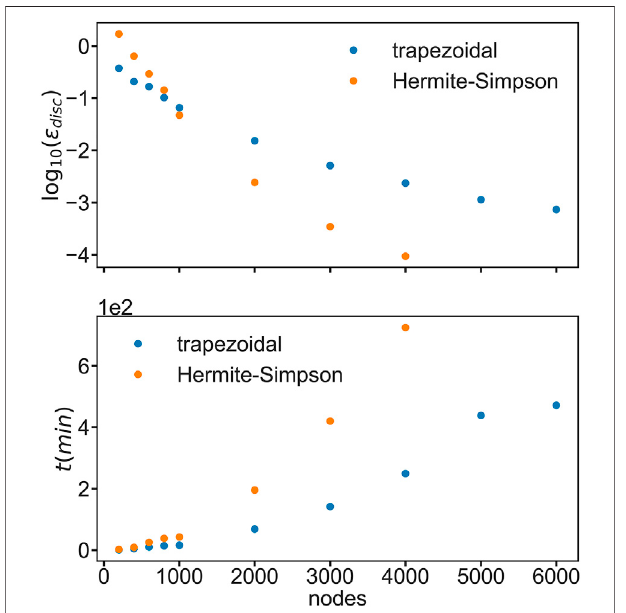
FIGURE 3 | Maximum relative local error (upper panel) and timing (lower panel) for trapezoidal (blue) and Hermite-Simpson (orange) as a function of the number of nodes.